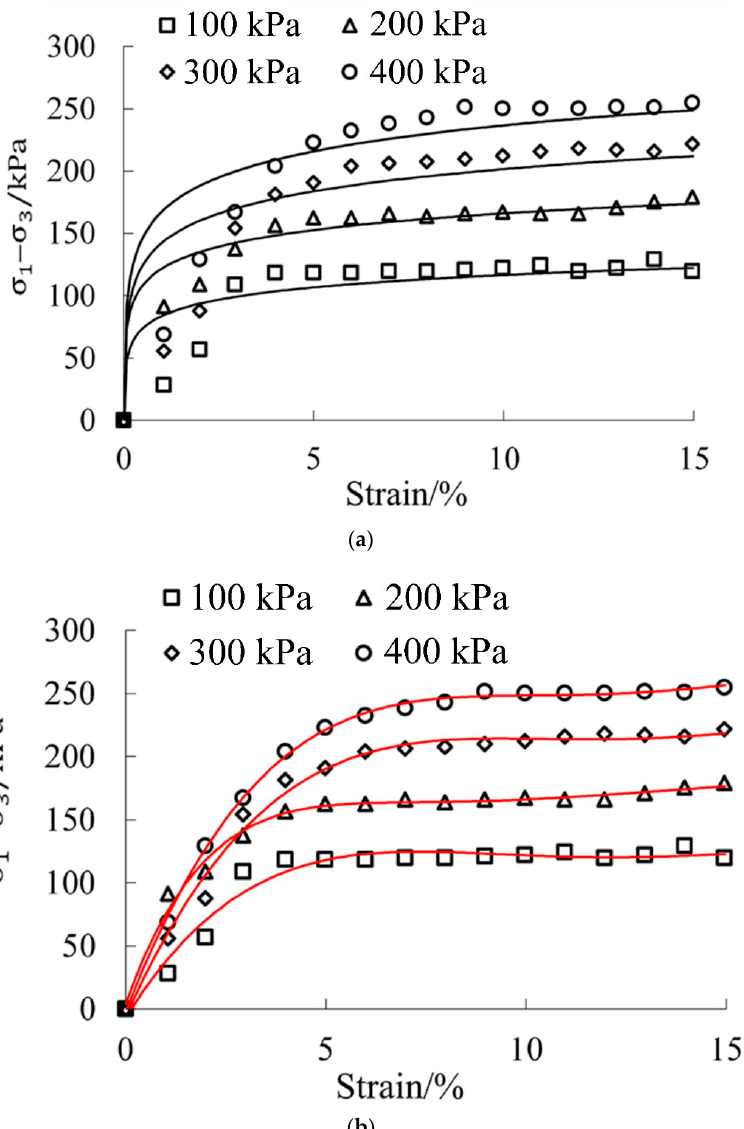
Figure 13. Comparison between test data and calculated results using different models. ( a ) Duncan– Chang model; ( b ) Shen model.